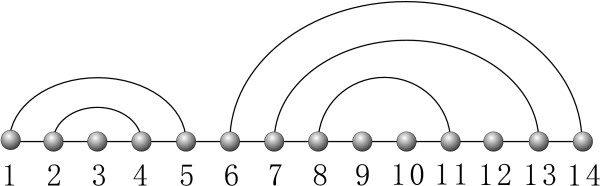
Secondary structure. Secondary structures are particular k-noncrossing diagrams, 2-noncrossing diagrams exhibit no crossings at all, therefore RNA secondary structures coincide with 2-noncrossing diagrams having minimum arc-length two.